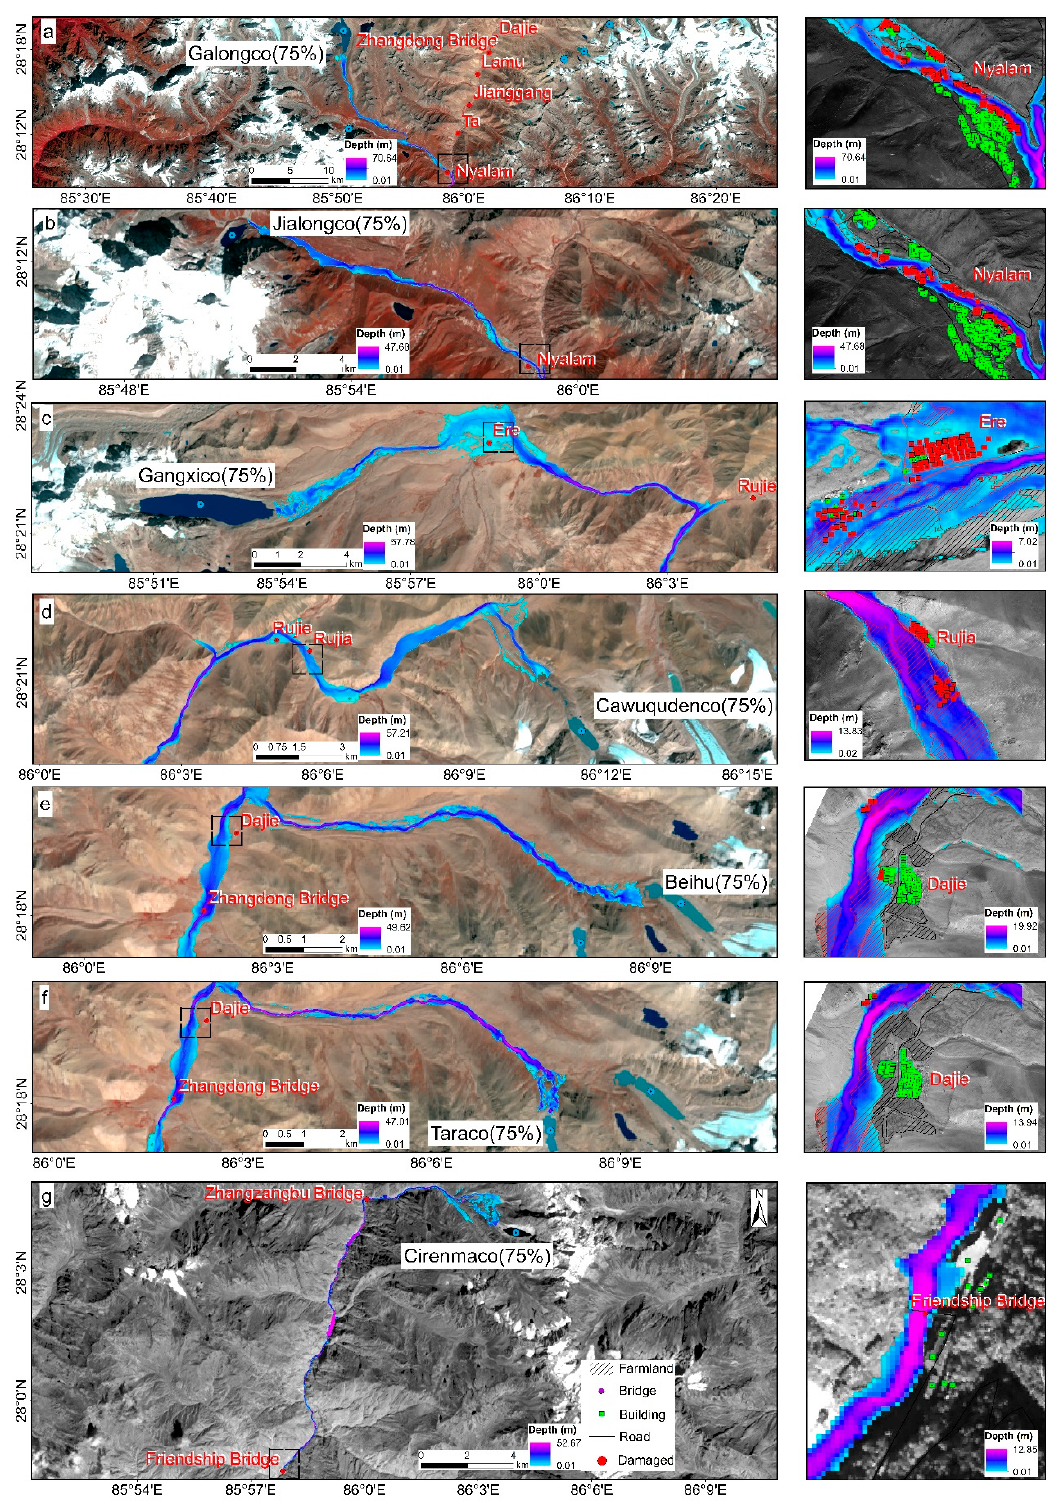
Figure 4. Inundation maps for GLOFs originating in ( a ) Galongco, ( b ) Jialongco, ( c ) Gangxico, ( d ) Cawuqudenco, ( e ) Beihu, ( f ) Taraco, and ( g ) Cirenmaco under a 75% drainage scenario.